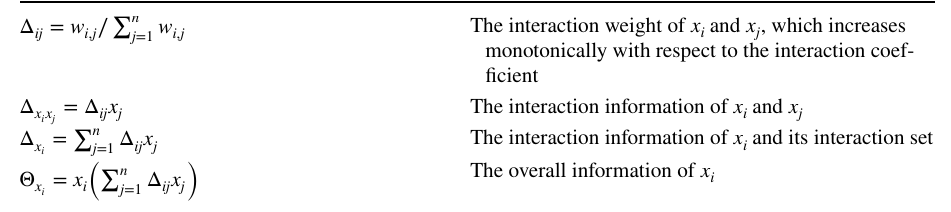
Formula Indicator for the NWIBM operator with p = q = 1